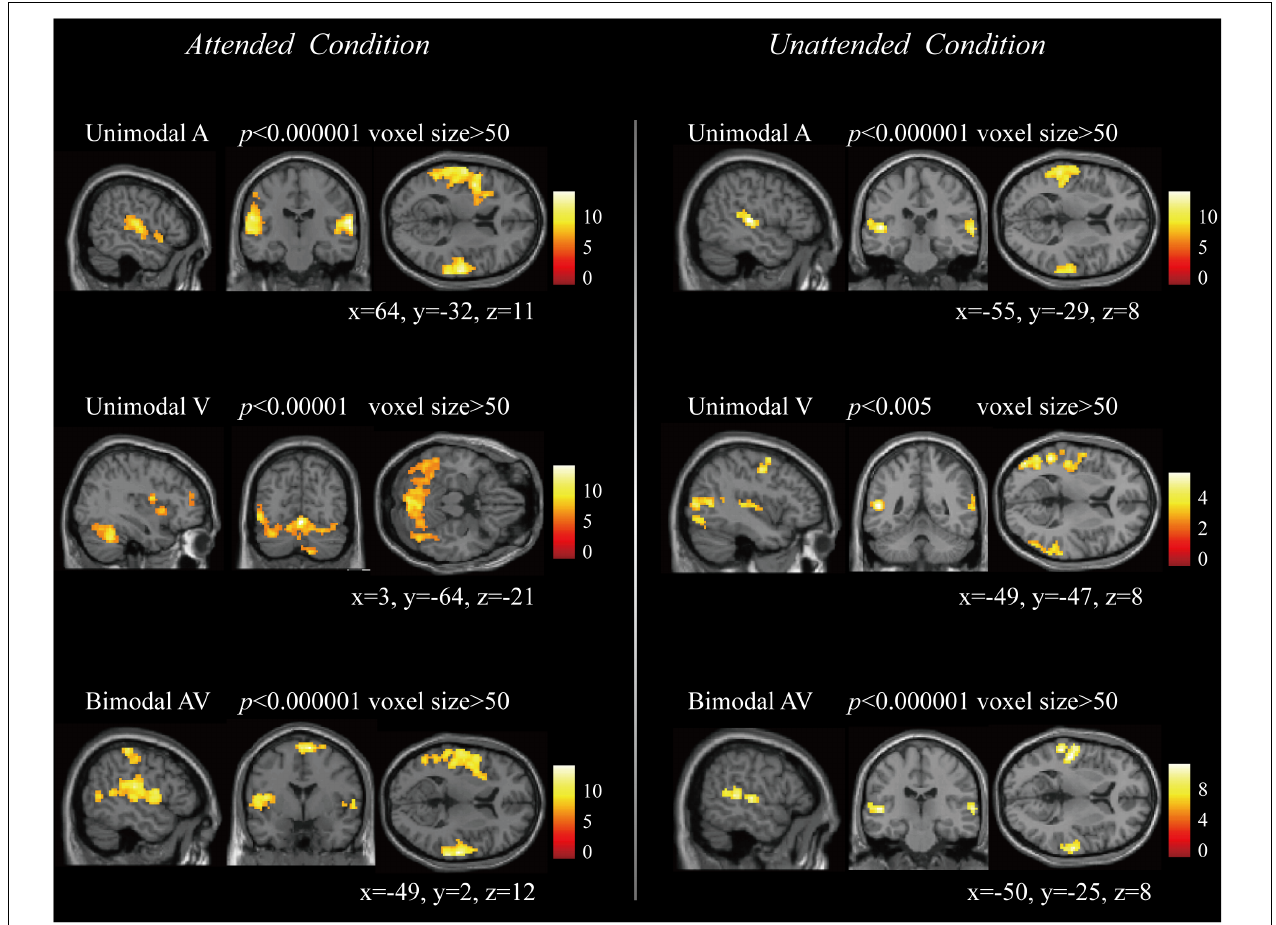
FIGURE 3 | The brain activation to unimodal A, unimodal V, and bimodal AV stimuli in attended and unattended conditions,